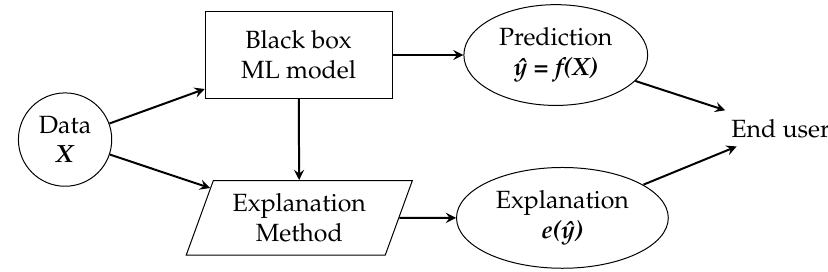
Figure 2. Explainable machine learning